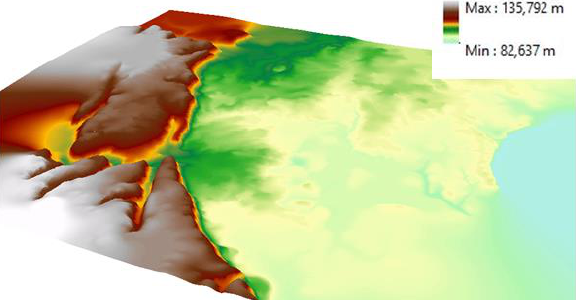
Figure 4. The digital terrain model of the investigated area